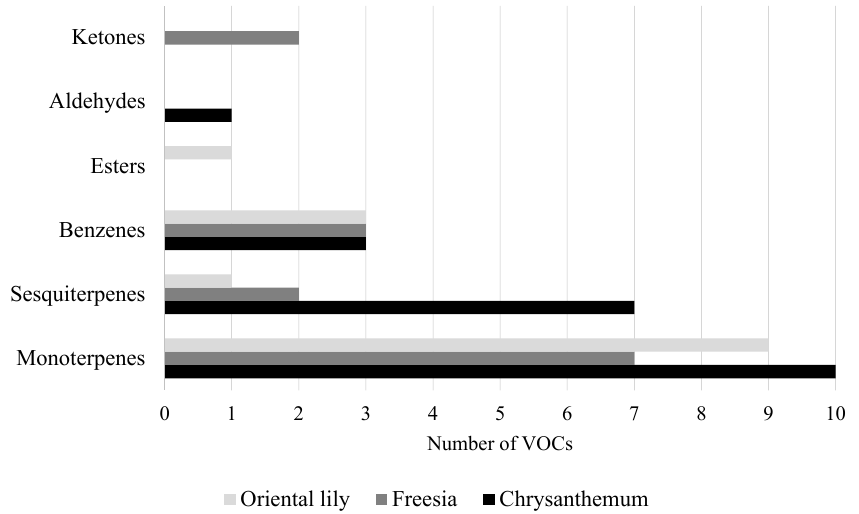
Figure 4. Number of VOCs detected by GC-MS analysis in flowers of oriental lily, freesia, and chrysanthemum, clustered by chemical groups.